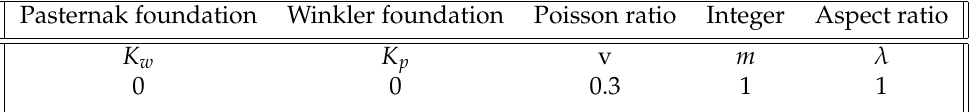
Table 1. Parameters for validation of the model